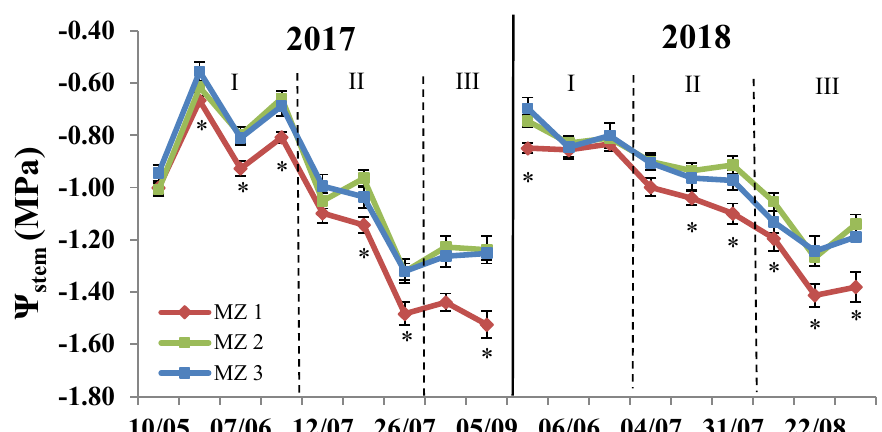
Figure 9. Seasonal course of midday stem water potential ( Ψ stem ) of vines in the management zones (MZs) during 2017 and 2018. Each point is the mean of 44, 56 and 20 vines for MZ 1, 2 and 3, respectively ± SE. Asterisks represent significant differences among MZs as determined by ANOVA ( α = 0.05).